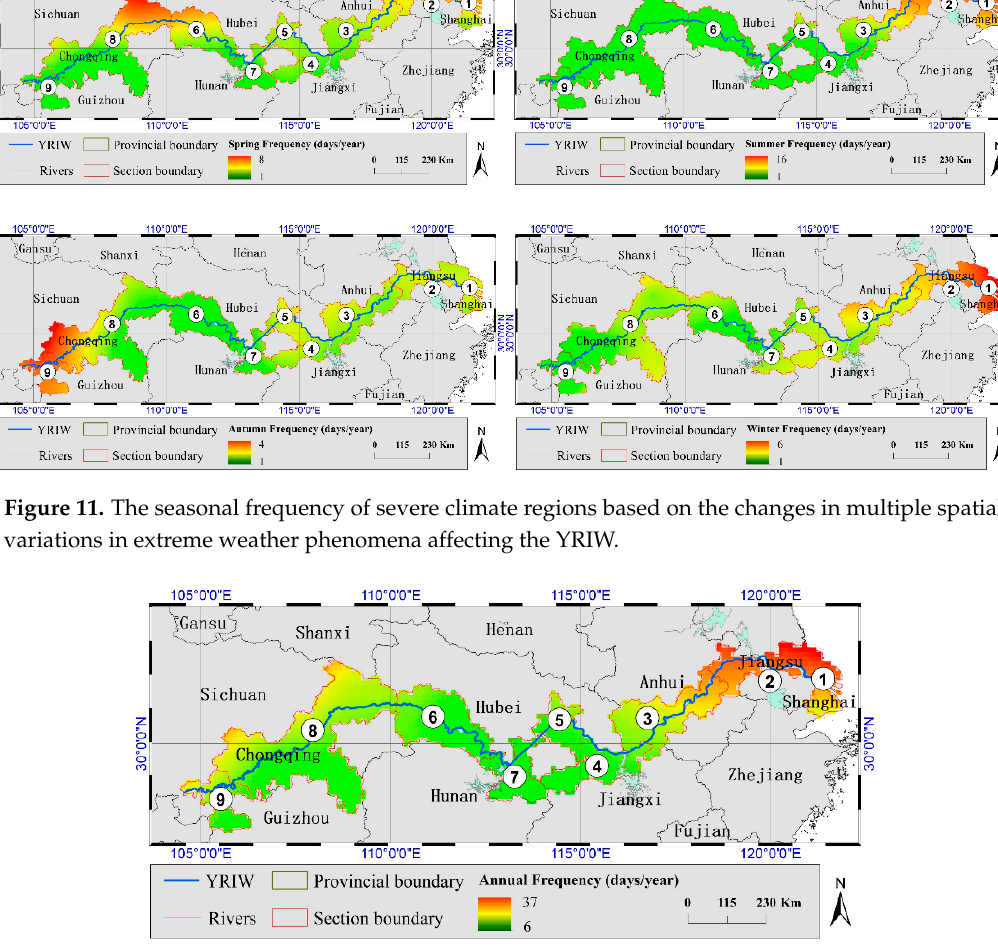
Figure 12. The total annual frequency of severe climate regions based on the changes in multiple spatial variations in extreme weather phenomena affecting the YRIW. Table 3. Characterizations of climate regions based on the analysis of spatial variation in extreme weather affecting transportation.